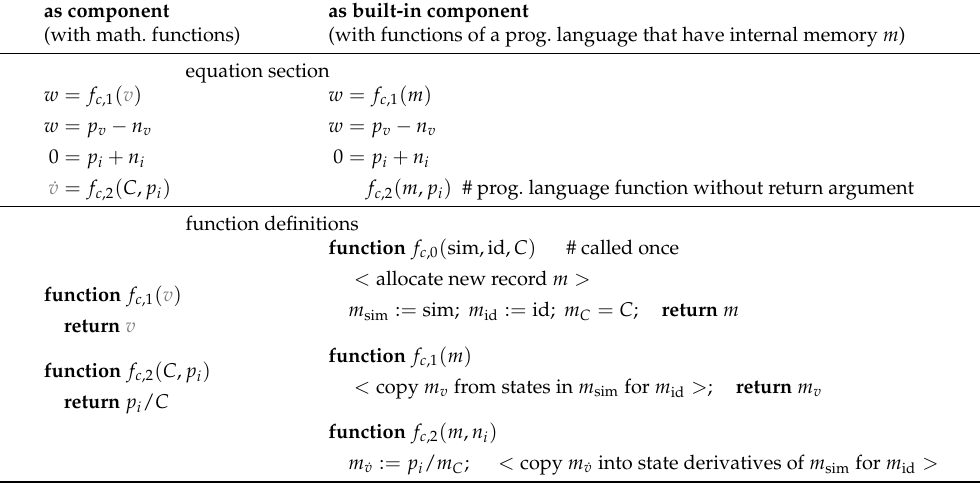
Table 1. The capacitor is defined as a component with mathematical functions (left column) and with functions that have an internal memory (right column) to hide the state and the state derivative of the component in the equation section. as component as built-in component (with math. functions) (with functions of a prog. language that have internal memory m